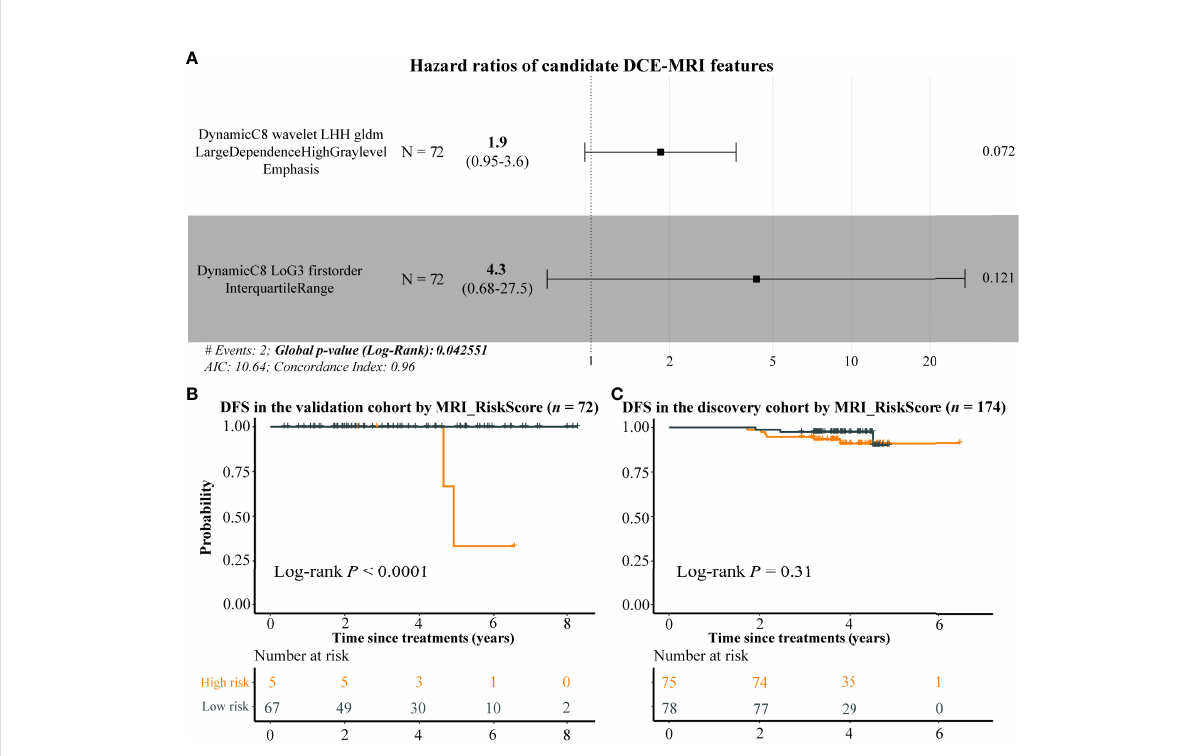
FIGURE 6 The potential prognostic ability of DCE-MRI features. Forest plot by using multivariate Cox regression analysis indicates that BIF3 and BIF4 were risk factors of BC (A) , and the Kaplan – Meier plots display the DFS differences between high and low MRI risk score BC samples in the validation and discovery cohorts (B, C) . DCE, dynamic contrast enhanced; BC, breast cancer; DFS, disease-free